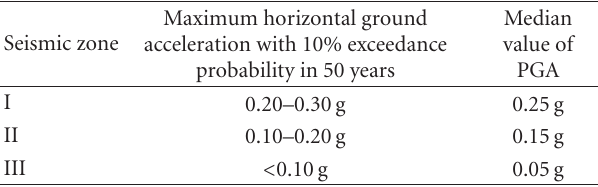
Table 5: Parameters of seismic zonation in